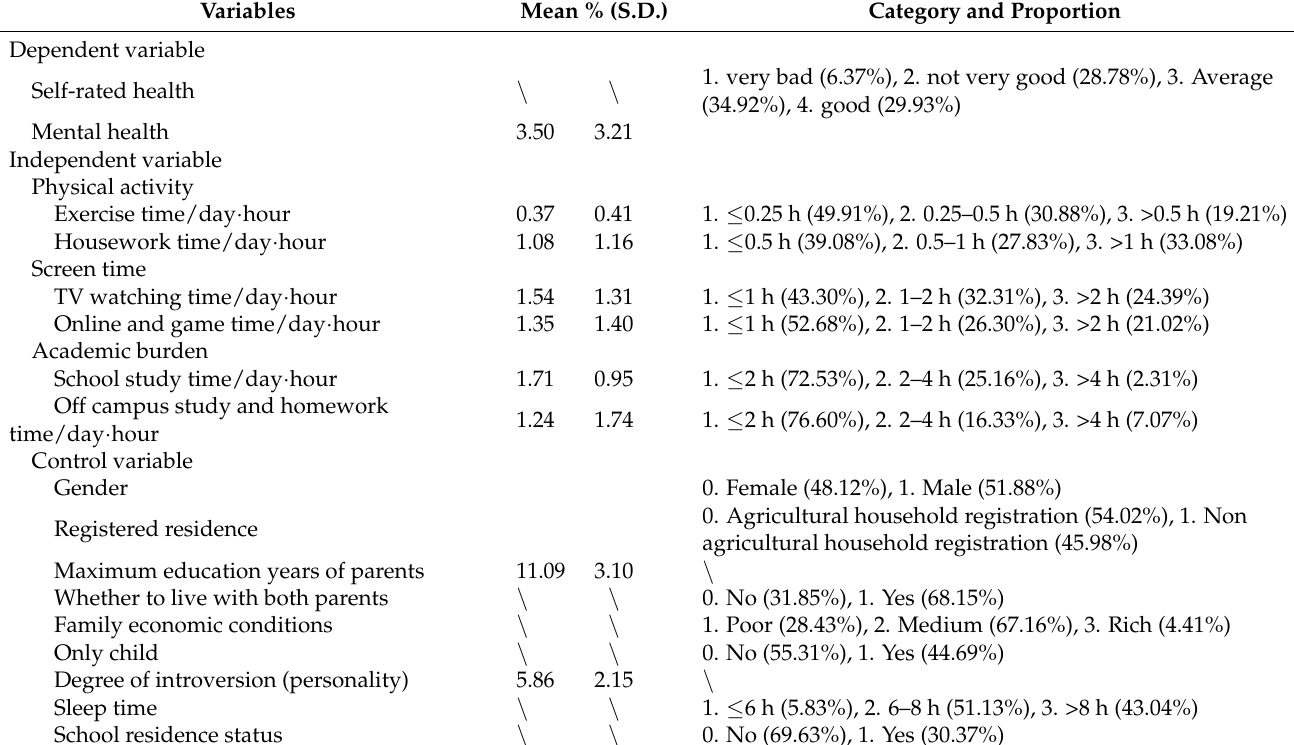
Table 1. Descriptive results for